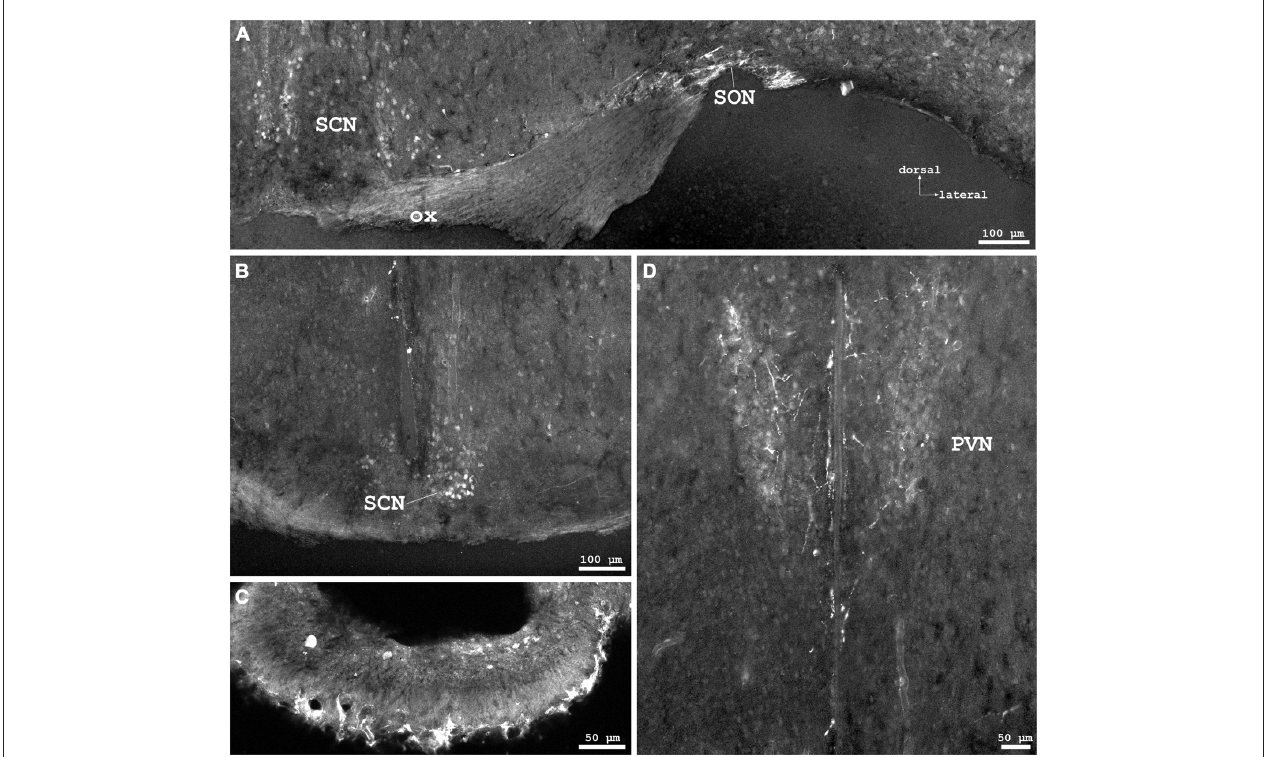
FIGURE 3 | Cygb-immunofluorescence in a frontal section of the mouse brain at the levels of approximately interaural +3.3–3.1 mm, corresponding to Figures 35–37 of the mouse brain atlas. (A) Overview (MIA) showing the optic chiasm (ox) and basal hypothalamus. Labeled cells were found in the supraoptic nucleus (SON) and in core and shell regions of the medial suprachiasmatic nucleus (SCN). In the posterior SCN (B) , neurons labeled with various strength were observed within the borders of the nucleus. (C) Median eminence: few small IR structures, mainly processes, were seen. (D) Faintly labeled neurons in the anterior magnocellular part of the hypothalamic paraventricular nucleus (PVN), where stronger labeled processes (probably axons) were present.